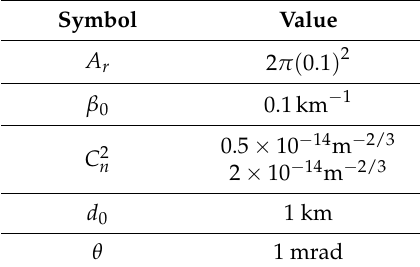
Table 2. System configuration.